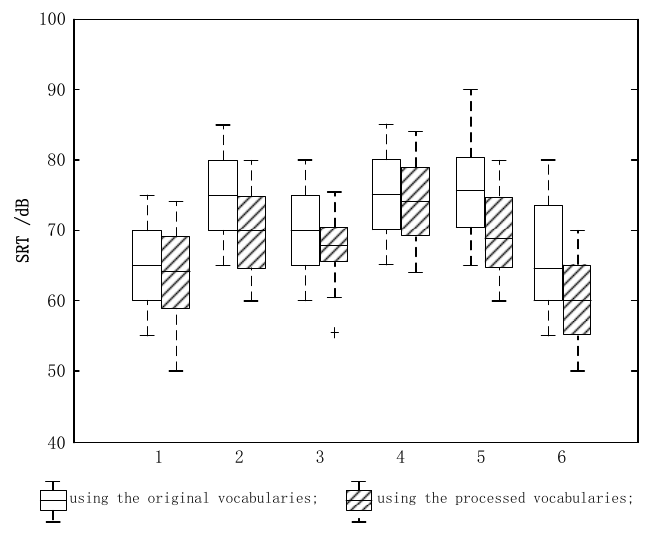
using the original vocabularies; using the processed vocabularies; Figure 7. Boxplot of SRT for the 60 dB car ‐ riding scenario. Figure 7. Boxplot of SRT for the 60 dB car-riding